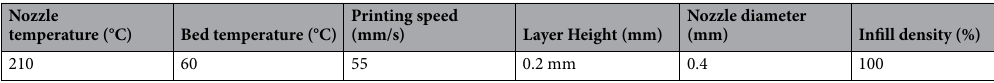
Nozzle temperature (°C)